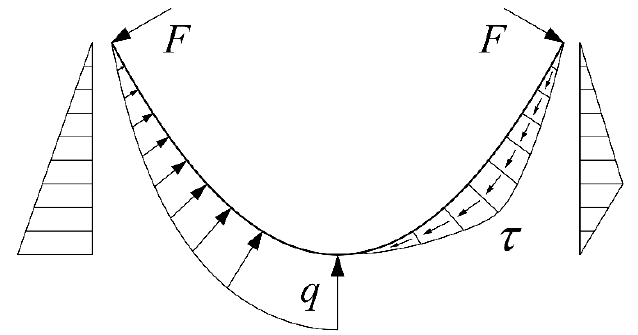
Figure 4. Schematic diagram of frost ‐ heaving force and the freezing force distribution in the parabolic channel.